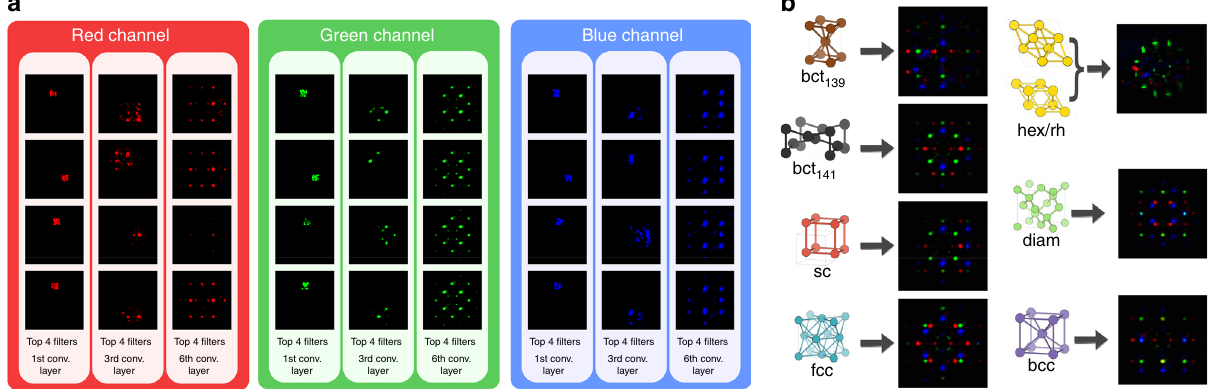
Fig. 5 Visualizing the convolutional neural network (ConvNet) attentive response maps. a Attentive response maps from the top four most activated fi lters of the fi rst, third and last convolutional layers for the simple cubic class. The brighter the pixel, the most important is that location for classi fi cation. Comparing across layers, we notice that the ConvNet fi lters are composed in a hierarchical fashion, increasing their complexity from one layer to another. At the third convolutional layer, the ConvNet discovers that the diffraction peaks, and their relative arrangement, are the most effective way to predict crystal classes. b Sum of the last convolutional layer fi lters for all seven crystal classes: the ConvNet learned crystal templates automatically from the data